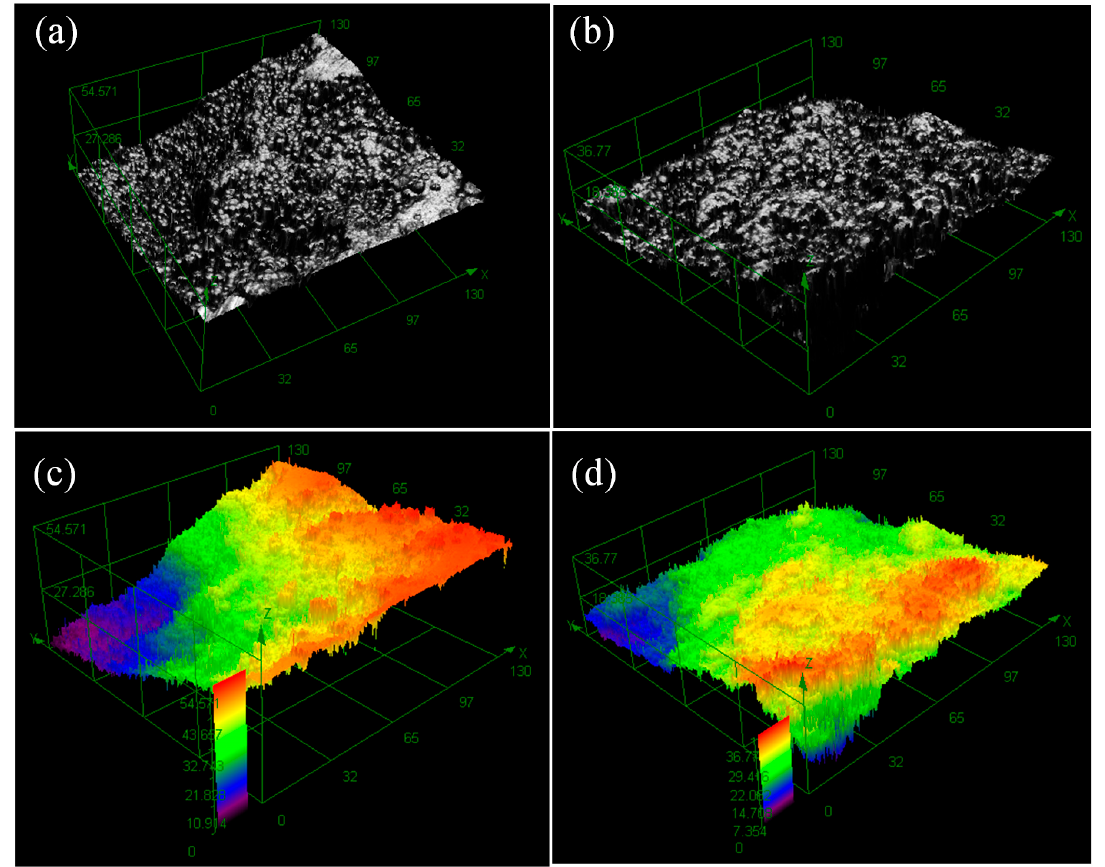
Figure 2. 3D measuring laser microscope images of the surfaces of coatings prepared by these two pretreatments: ( a ) 3D brightness image and ( c ) 3D height image of sensitization-activation pretreatment; ( b ) 3D brightness image and ( d ) 3D height image of Pd-free activation pretreatment.